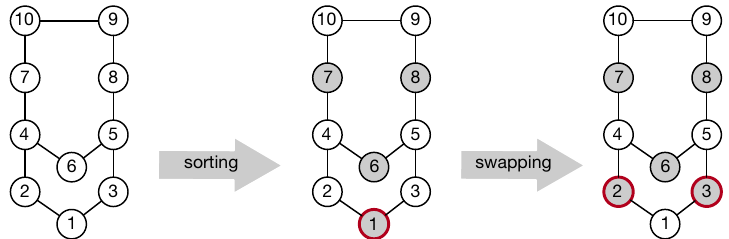
Figure 5. Basic idea of the one-k-swap algorithm in the independent set augmentation. Before and after swapping, the gray vertices form two independent sets with the sizes of four and five,